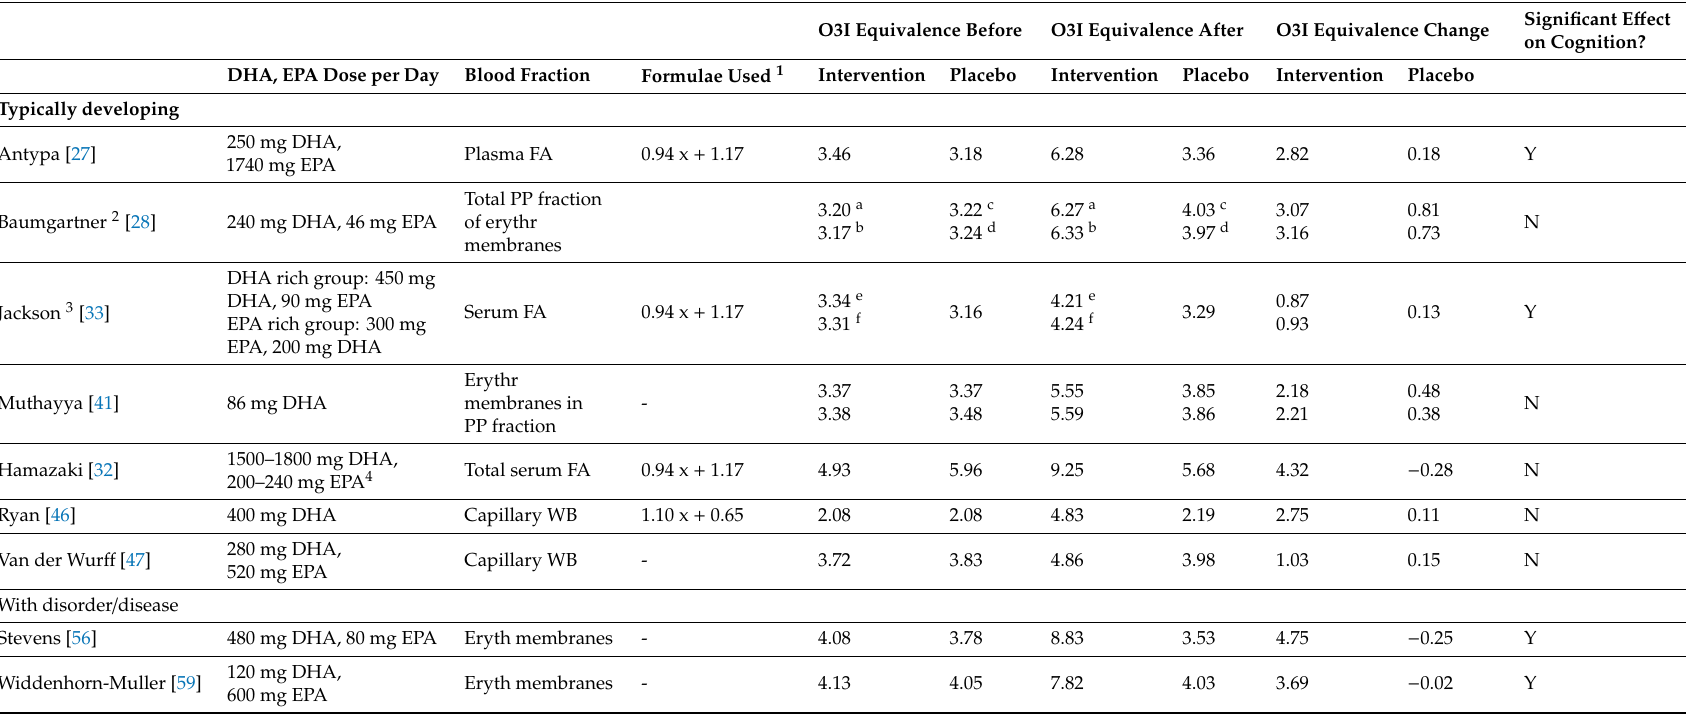
Significant E ff ect on Cognition?